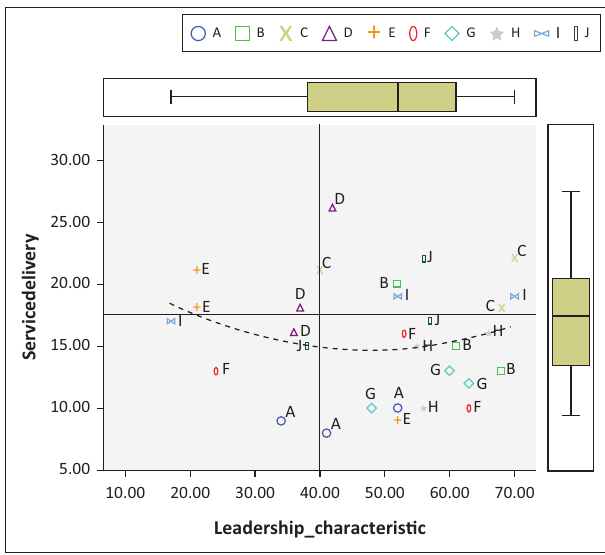
FIGURE 2: Service delivery versus leadership characteristics.